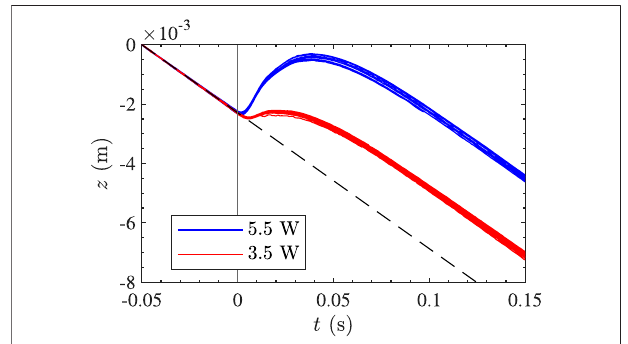
FIGURE 2 | Examples of (10 and 24) measured trajectories from two separate measurements with a plasma power of 5.5 and 3.5 W respectively. The vertical line at t = 0 represents the moment the plasma power source is switched off. The dashed line represents the terminal velocity of the particles prior to the moment the plasma was switched off and has a slope of 4.58 cm s − 1 . For each particle, z is de fi ned as its vertical position relative to that at t = − 0.05